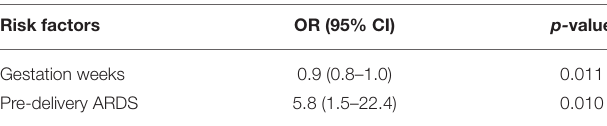
TABLE 2 | Multivariable logistic regression analysis of risk factors of fetal intrauterine death in the period of pre-delivery. Risk factors